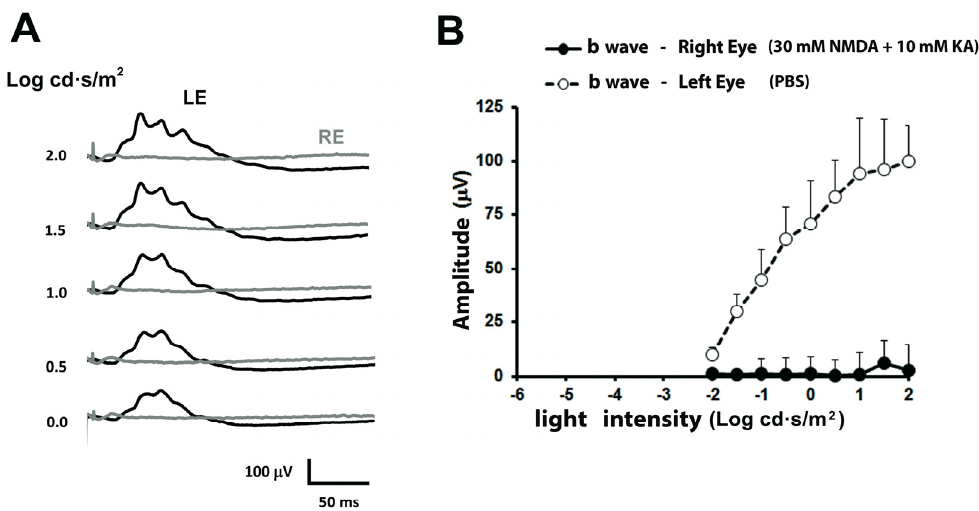
Figure 2. Photopic electroretinographic responses after intraocular injection of NMDA and Kainate. ( A ) Electroretinographic records obtained in the right eye injected with 30 mM NMDA and 10 mM KA (grey trace) and left eye injected with PBS (black trace) of the same animal shown in Figure 1, under increasing light intensities. ( B ) Relationship between the amplitude of the photopic b-wave and the light intensity. The values shown in ( B ) correspond to the mean and the standard deviation, n = 8.